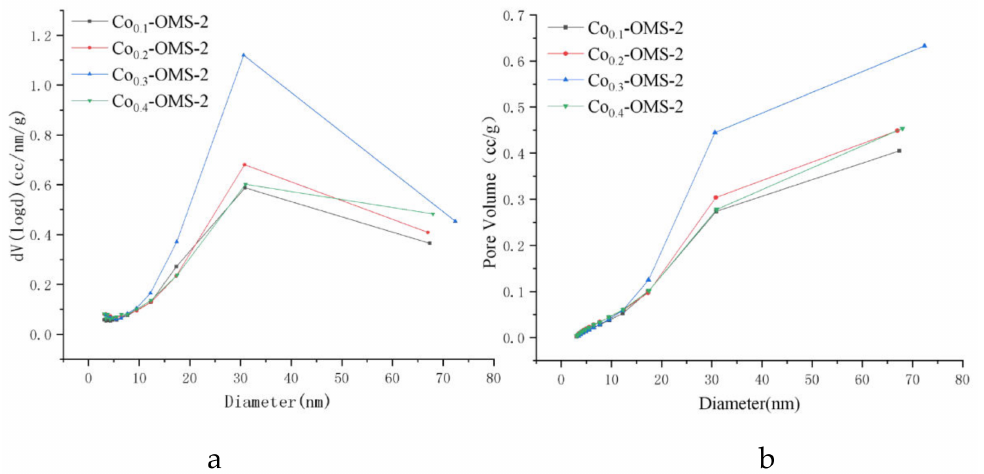
Figure 3. Nitrogen gas absorption and desorption pore size distribution of OMS-2. ( a ) adsorption, ( b ) desorption.